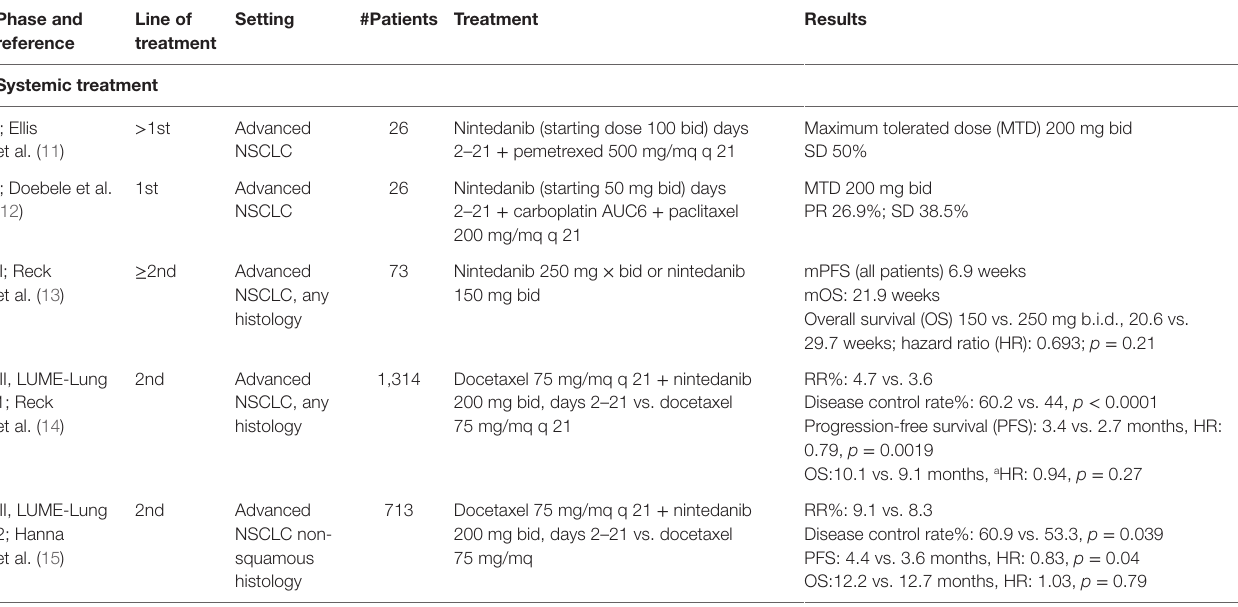
TABLe 1 | Randomized clinical studies with nintedanib in non-small cell lung cancer (NSCLC). Phase and